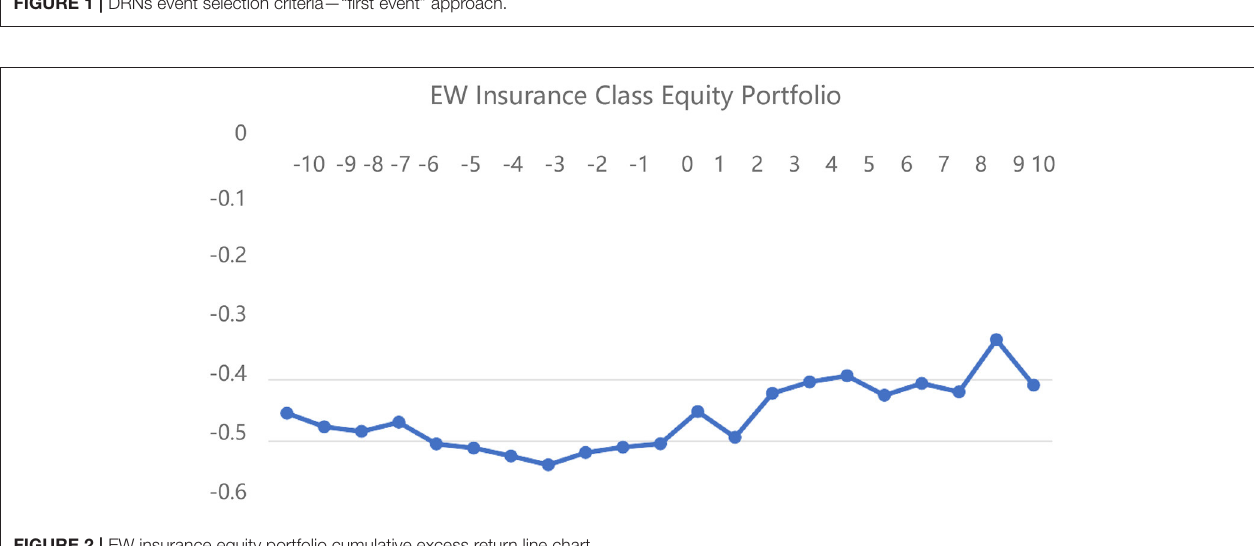
FIGURE 2 | EW insurance equity portfolio cumulative excess return line chart.